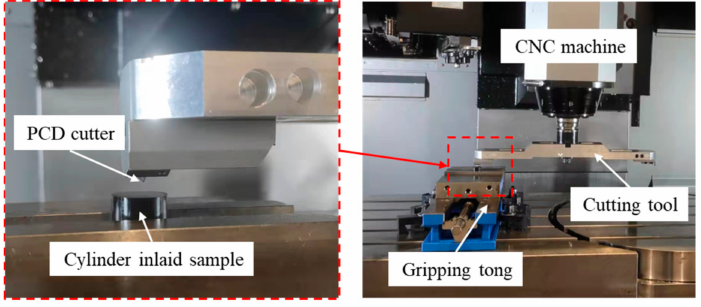
Figure 2. Experimental